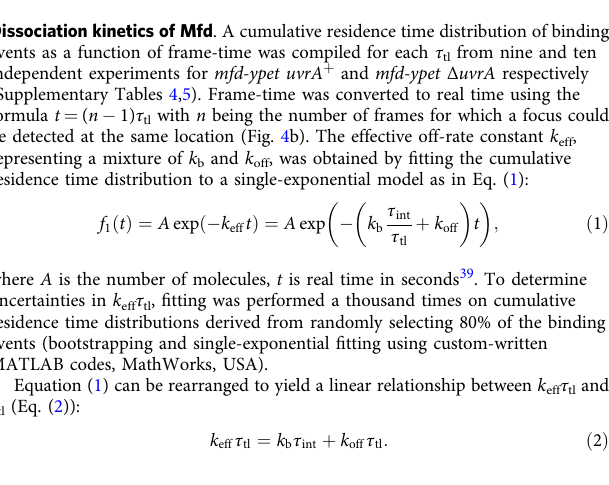
drawn in MicrobeTracker 55 . For quanti fi cation of binding events, peaks were detected in the reactivation phase (Fig. 3f: frames 31 − 50, Fig. 4b: frames 51 − 100, Table 1 and Fig. 5: frames 101 − 200). Peaks were detected by fi rst applying a discoidal average fi lter (inner radius of one pixel, outer radius of three pixels), then selecting pixels above the intensity threshold (mean + 10× s.d.). Secondly, only peaks with the full width at half maximum smaller than fi ve pixels (530nm) were kept to reject broad cytosolic features. Peaks detected within two-pixel radius (213 nm) in consecutive frames were considered to belong to the same binding event. Dissociation kinetics of Mfd . A cumulative residence time distribution of binding events as a function of frame-time was compiled for each τ tl from nine and ten independent experiments for mfd-ypet uvrA + and mfd-ypet Δ uvrA respectively (Supplementary Tables 4,5). Frame-time was converted to real time using the formula t = ( n − 1) τ tl with n being the number of frames for which a focus could be detected at the same location (Fig. 4b). The effective off-rate constant k eff , representing a mixture of k b and k off , was obtained by fi tting the cumulative residence time distribution to a single-exponential model as in Eq. (1):